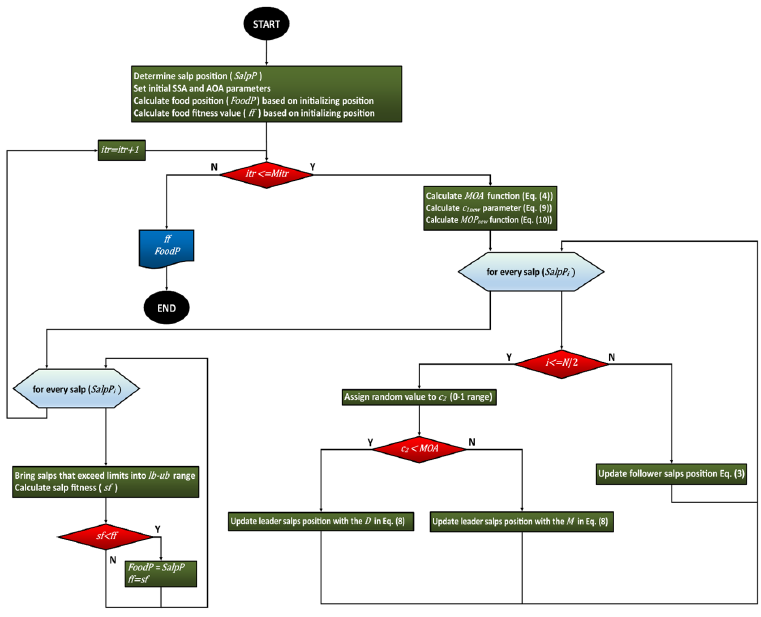
Fig. 3. Flowchart of